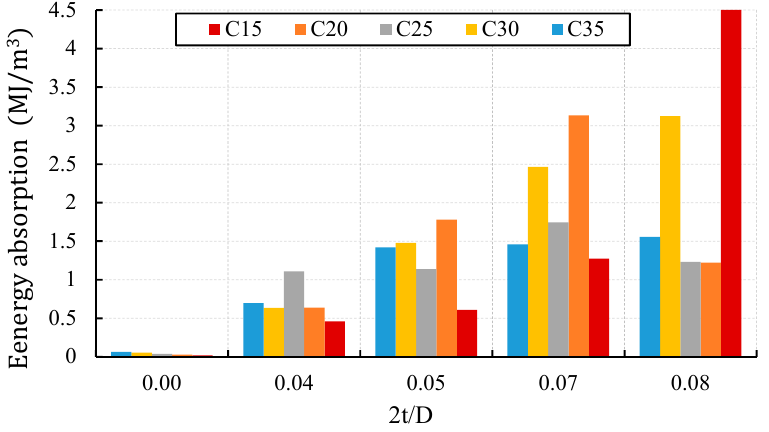
Figure 20. Energy absorption capacity for different concrete classes and 2t/D ratios.